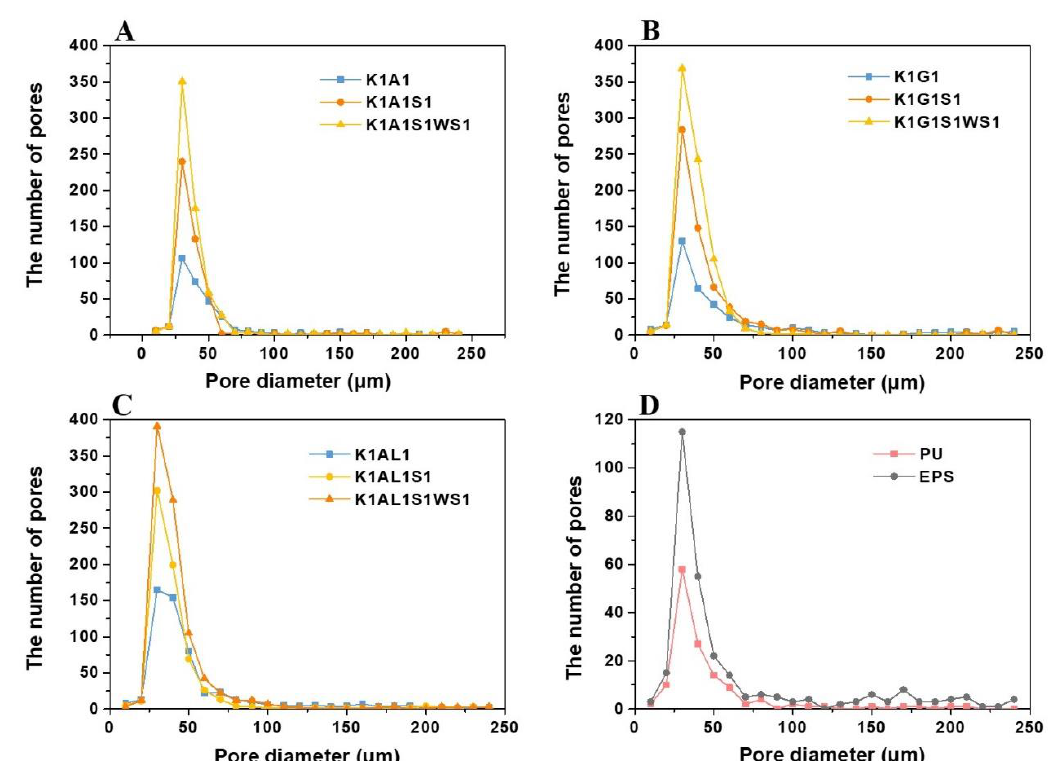
Figure 2. Pore size distribution of KGM-based aerogels ( A – C ); PU and EPS ( D ).